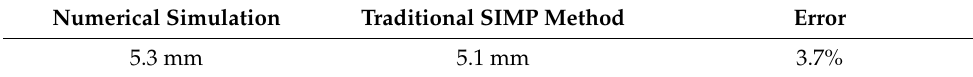
Table 2. Maximum displacement at the output port of